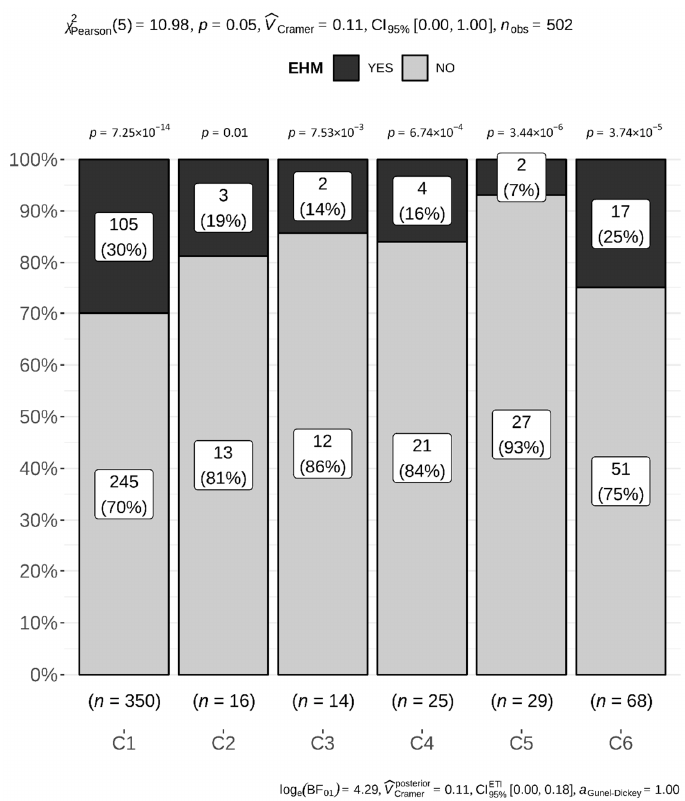
Figure 2. Six breed clusters (1–6) according to similar genetical background are arranged from left to right. EHM frequencies per cluster are shown as percentage in a stacked bar plot (dark grey). The p -values above distinct stacked bars compare the proportions of EHM-affected (dark gray) individuals versus unaffected (light gray) animals inside of every particular breed cluster. The chi-square test finds only a suggestive relationship between breed clusters and EHM ( p = 0.05, low evidence against the null hypothesis). Also, the effect of this relationship is small (V Cramer = 0.11 [21]). The Bayes Factor (BF) supports this result by indicating a very strong evidence for the null hypothesis that there is no relationship between EHM and breed (log(BF01) = 4.29 [22]). The Bayesian effect size also supports this conclusion with a small effect size (V Cramer = 0.15; 95% Highest Density Intervals 0.09; 0.20).